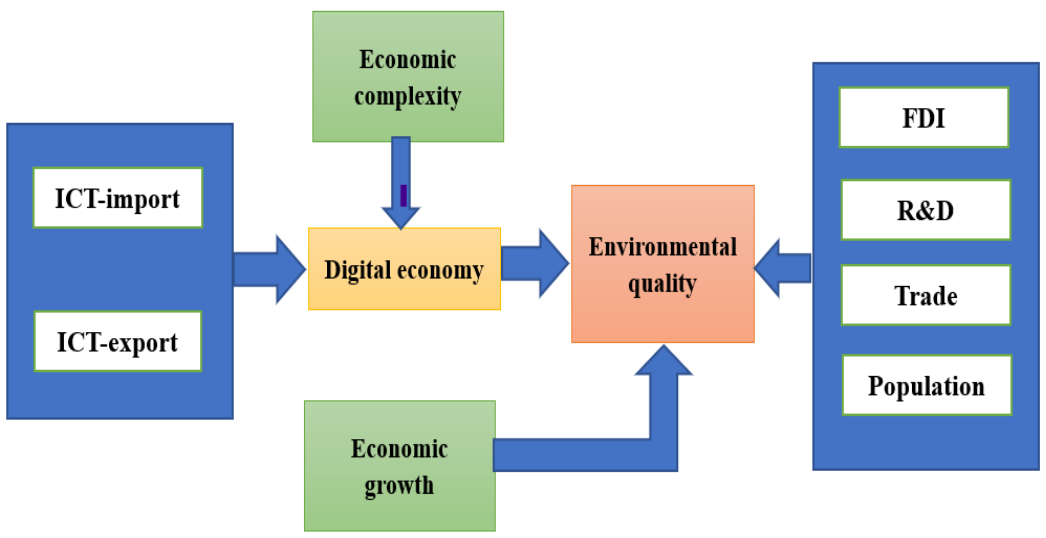
Figure 1. The Conceptual framework of the model. Source: authors’ own der ivations